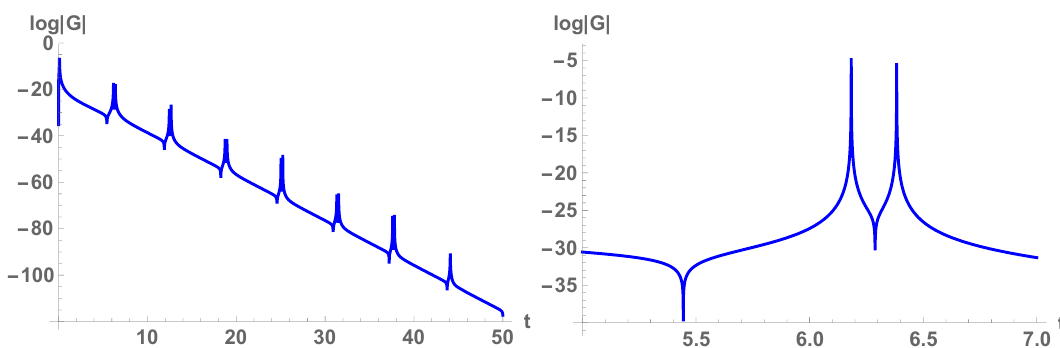
Figure 10. The black hole correlator G R (∆ t, ∆ ϕ = 0 . 1) as given in (5.7). We take R = r + = 1 BH and (cid:15) = 10 − 10 . The correlator decays exponentially for t > 0 ; note that each subsequent (small) peak at t > 0 come from the contribution of an “image” m > 0 . The “double-peak” structure (apparent from the close-up on the right) is typical for ∆ ϕ 6 = 0